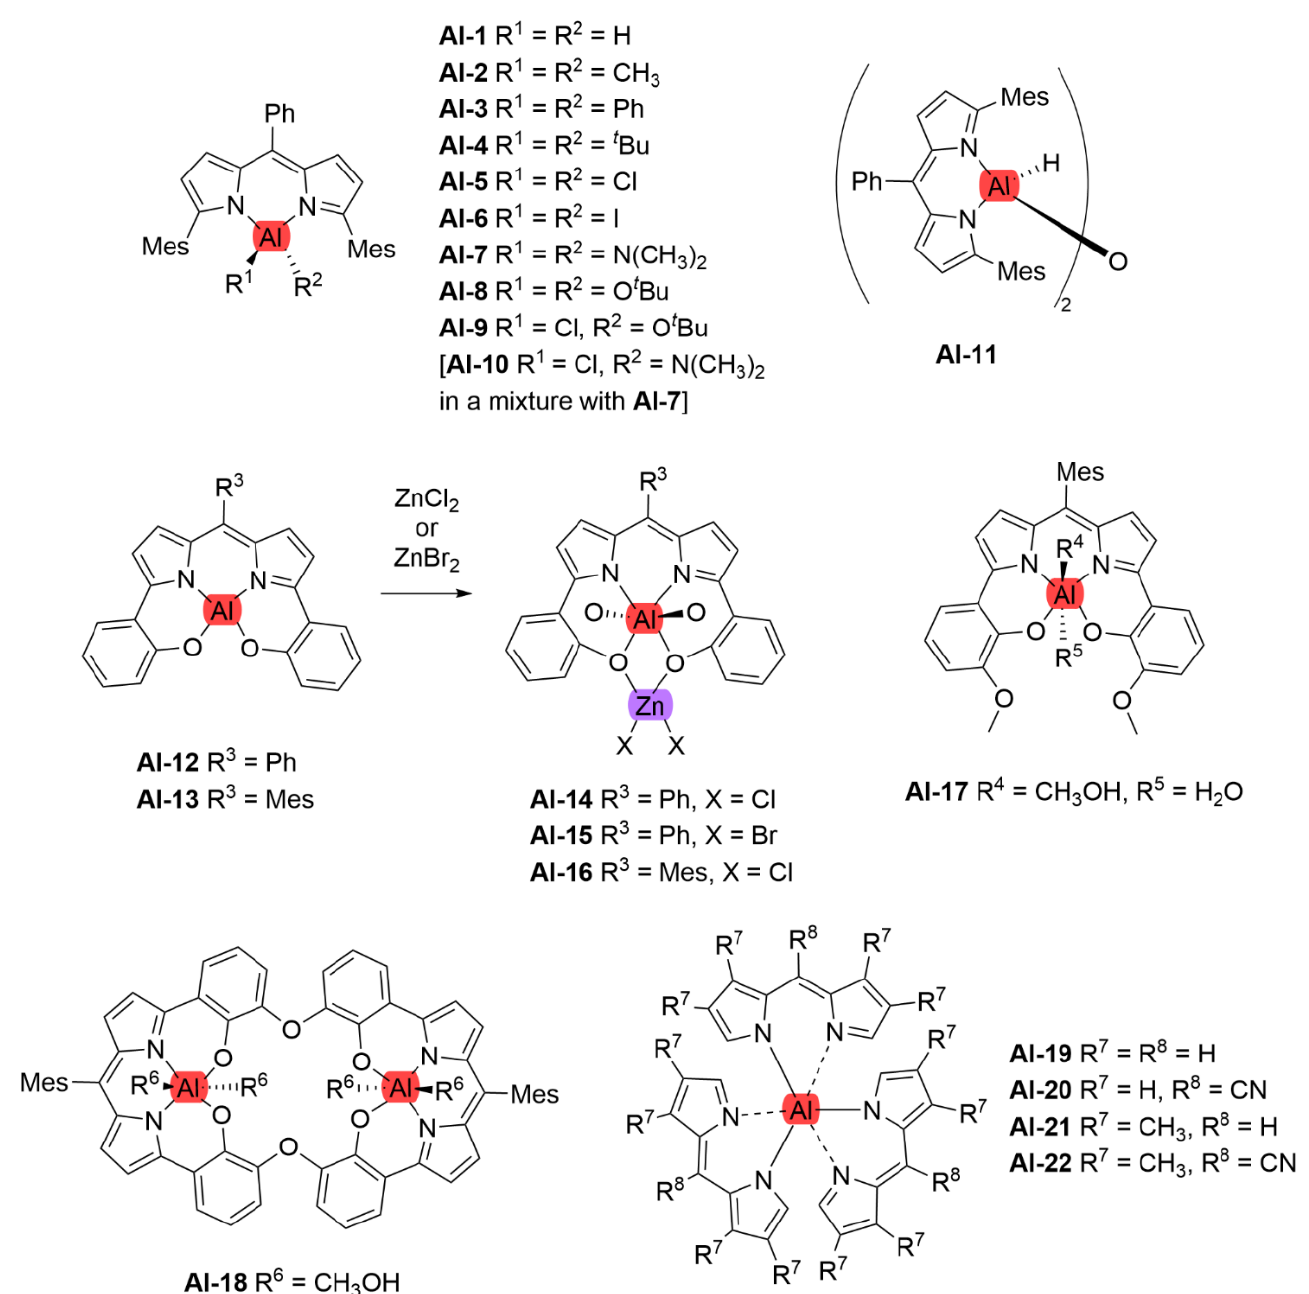
Figure 33. Several (dipyrrinato)Al(III) complexes, such as AlDIPYs Al-(1–13,17) and tris(dipyrrinato)Al(III) Al-(19–22) , reported in literature [119,204,205].